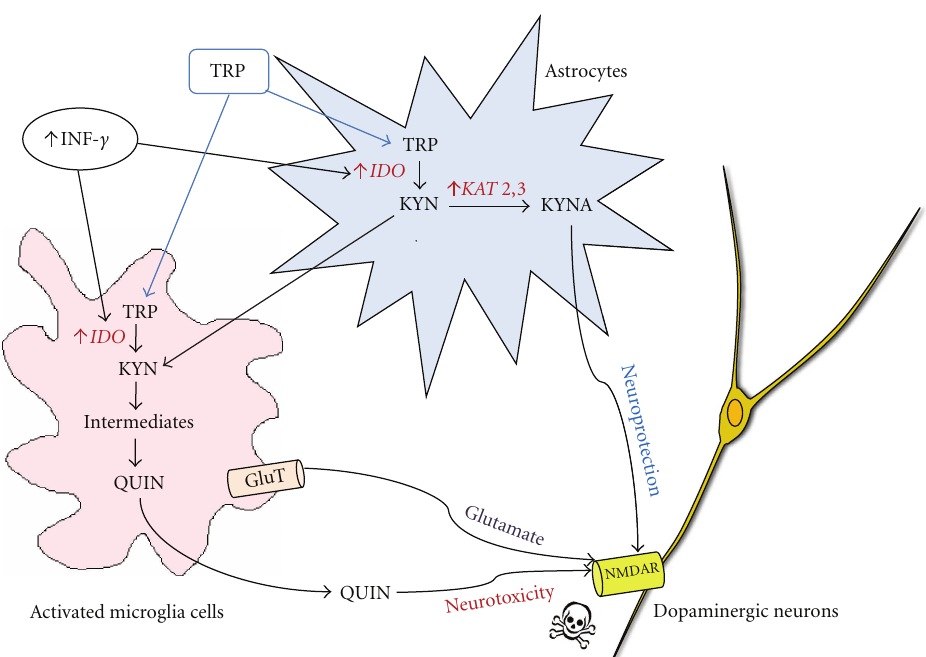
Figure 4: Model for Kynurenine pathway interactions between astrocytes, neurons, and microglia during brain inflammation. Abbreviations: TRP: tryptophan; IDO: Indoleamine 2,3-dioxygenase; KYN: kynurenine: QUIN: quinolinic acid; NMDAR: NMDA receptor; KAT: Kynurenine aminotransferase; GluT: glutamate transporter.